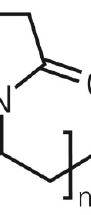
Figure 1. Structure of poly(vinylpyrrolidone) (PVP).